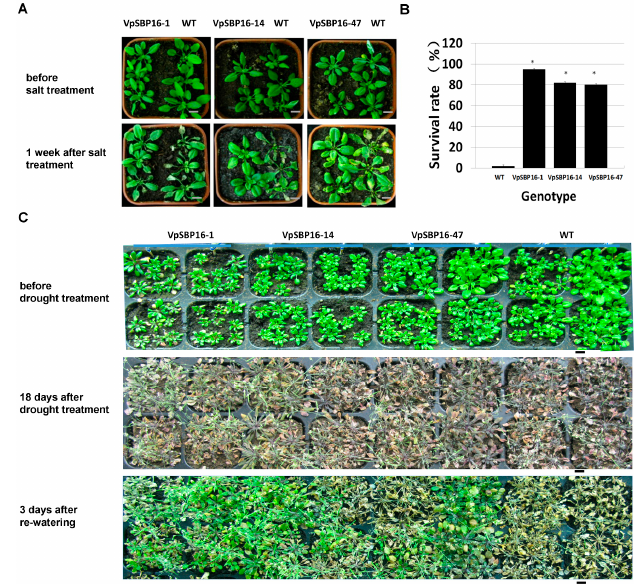
Figure 6. Growth of WT and VpSBP16 transgenic A. thaliana plants in pots under non-stress or osmotic stress conditions. ( A ) Representative photographs of 3-week-old WT and transgenic lines before salt treatment and after salt treatment for 1 week. The experiments were repeated three times with consistent results, scale bars: 1 cm.( B ) Survival rates of WT and transgenic lines 3 days after re-watering. Each data point is the mean of three replicates. The error bars indicate the SD. ( n = 50 for each genotype, * 0.01< p < 0.05, one-way ANOVA). ( C ) Representative photographs showing the phenotype of plants before drought, 18 days after drought treatment and 3 days after re-watering. The experiments were repeated three times with consistent results, scale bars: 1